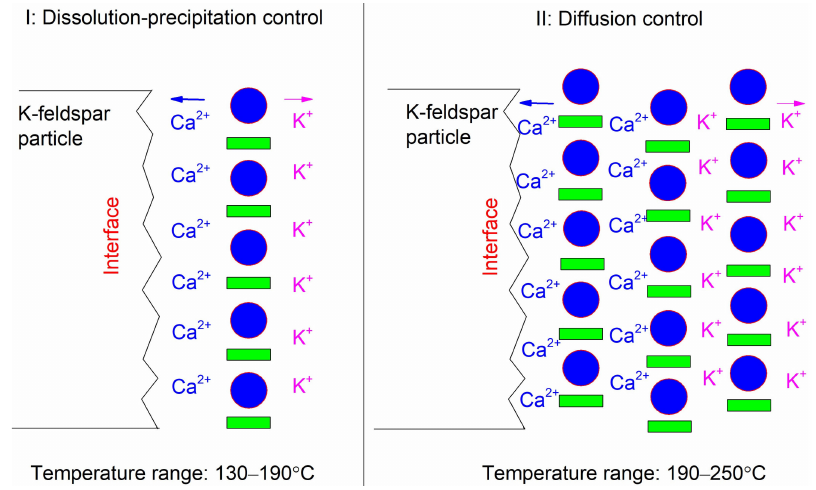
Figure 10. Hydrothermal dissolution mechanism of K-feldspar from 130 ◦ C to 250 ◦